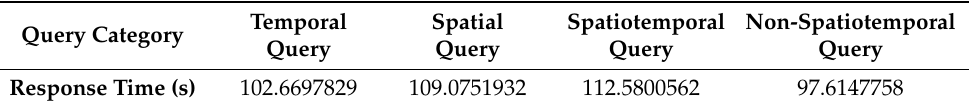
Table 6. Average response